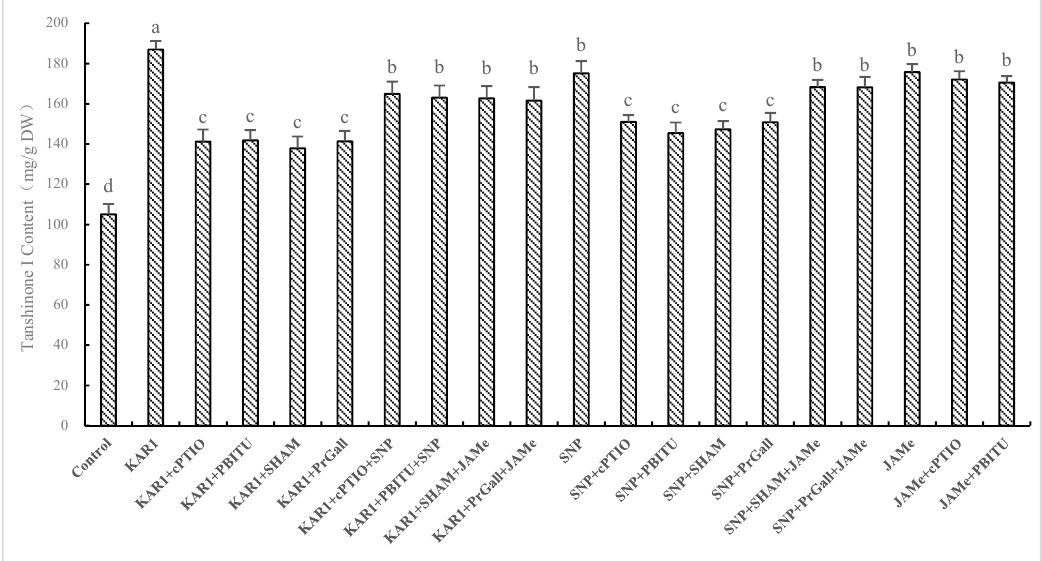
5 of 9 Figure 5. Effects of inhibitors on KAR 1 -induced NO generation in S. miltiorrhiza hairy root. S. miltiorrhiza hairy root treated with KAR 1 , and various inhibitors were harvested at 12 h after KAR 1 and JA contents were determined. Inhibitors were pretreated 1 h before treatment of KAR 1 . The control received vehicle solvent only. Data are means of three replicates ± SD. Different letters indicate significantly different values according to one-way ANOVA followed by Tukey’s test ( p < 0.05). 2.4. Dependence of KAR 1 -Stimulated T-I Production on NO Accumulation as well as JA production It has been exhibited in our experiments that NO generation and production of JA were early events in hairy root of S. miltiorrhiza responding to KAR 1 . Whilst little information about whether NO and JA participated in KAR 1 -induced accumulation of T-I has been known. So we investigated the influence of scavengers and inhibitors of JA and NO on production of T-I induced by KAR 1 . As